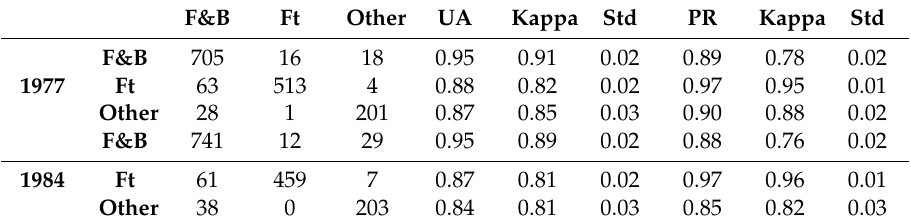
Table B2. LULCC category-based accuracy assessment for 1977 and